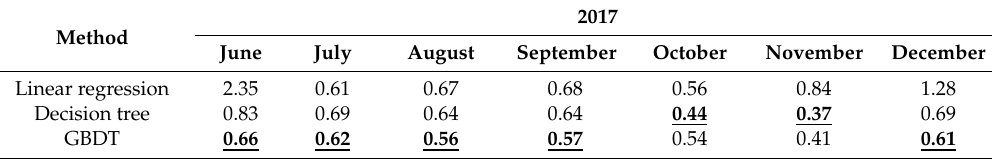
Table 15. RMSE for each method per month. (bold and underline means a best value of each month).